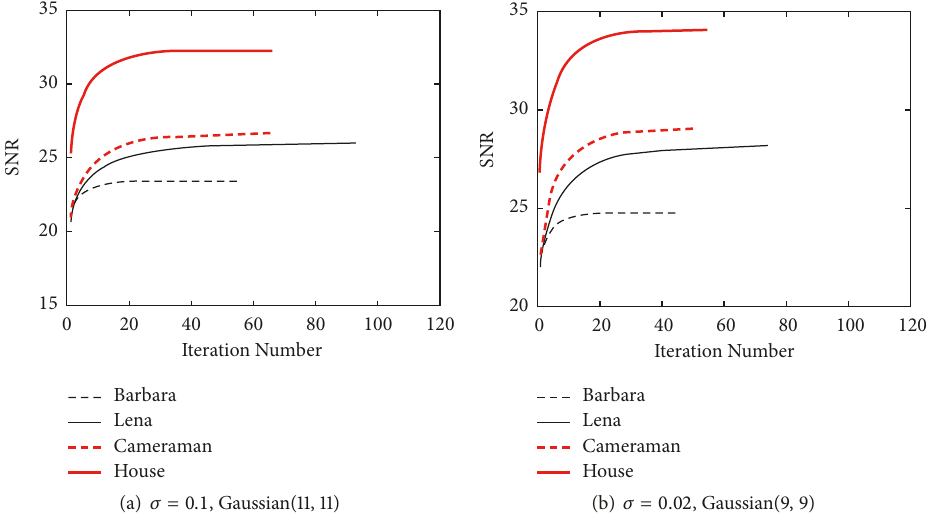
Figure 4: The changes of SNRs versus iteration number for test images about Gaussian